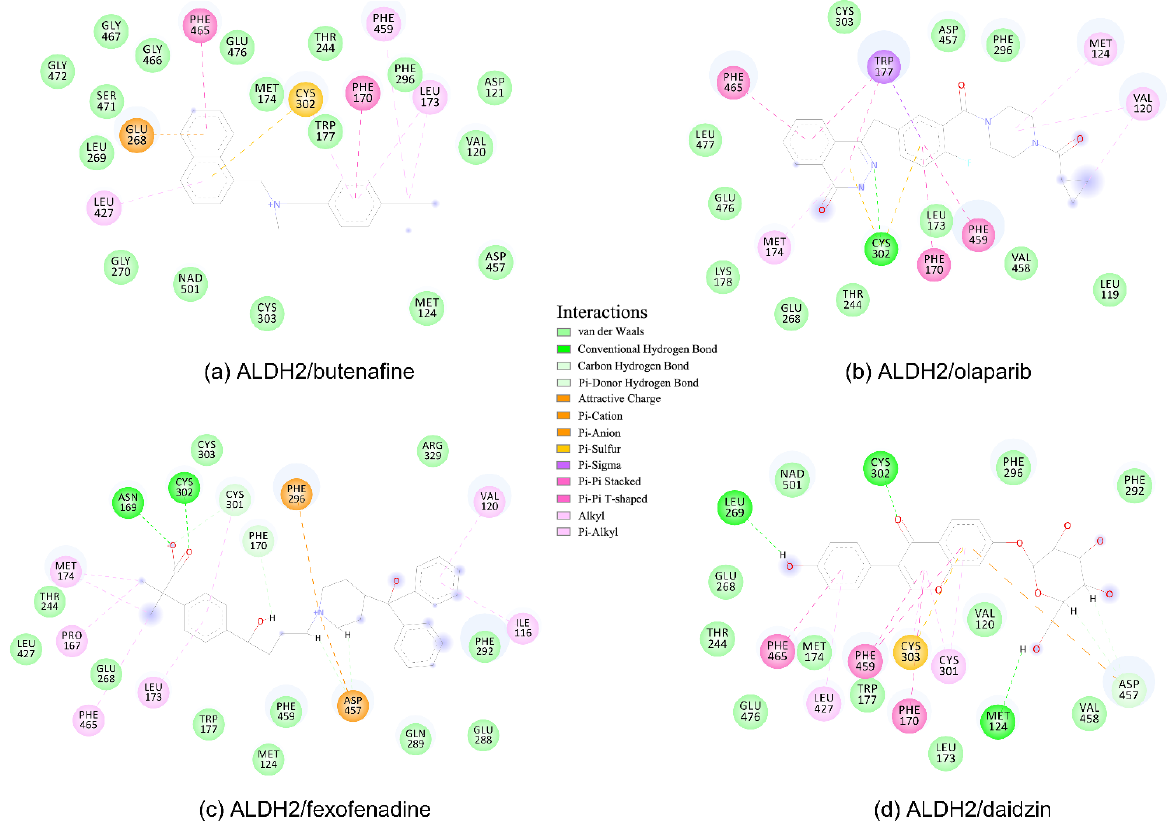
Figure 4. 2D diagrams of receptor–ligand interactions for ALDH2 complexes with butenafine ( a ), olaparib ( b ), fexofenadine ( c ), and daidzin ( d ). The cofactor NAD + is treated as one residue of the receptor with an ID of 501. The left moieties of the inhibitors enter into the bottom of the ALDH2 substrate-binding tunnel, while the right parts lie in the tunnel entrance (Figure 3a). Averaged structures from the last 10 ns simulations were used to generate the diagrams, and interacting residues and interaction types are shown with different colors.